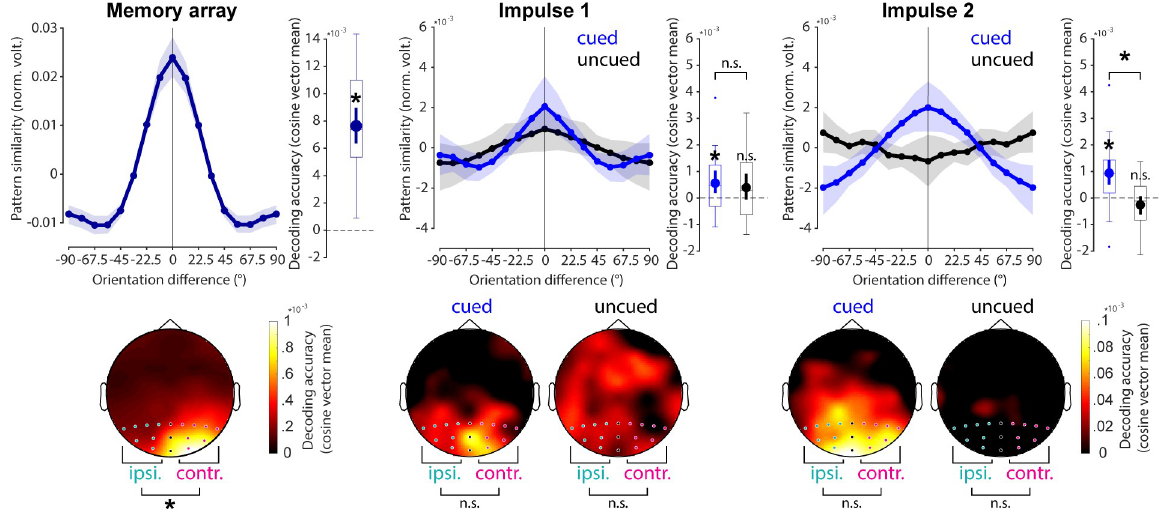
Fig 3. Decoding results. Top row: Normalised average pattern similarity (mean-centred, sign-reversed Mahalanobis distance) of the evoked neural responses (100 to 400 ms relative to stimulus onset) as a function of orientation similarity, and decoding accuracy (cosine vector means of pattern similarities). Error shadings and error bars are 95% CI of the mean. Asterisks indicate significant decoding accuracies ( p < 0.05, one- sided) or differences ( p < 0.05, two-sided). Bottom row: Decoding topographies of the searchlight analysis. Posterior channels used in all other decoding analyses are highlighted. Ipsilateral (‘ipsi.’) and contralateral (‘contr.’) channels used to test for item lateralisation are highlighted in turquoise and pink, respectively. Data available at osf.io/cn8zf. norm. volt., normalised voltage; n.s., not significant.